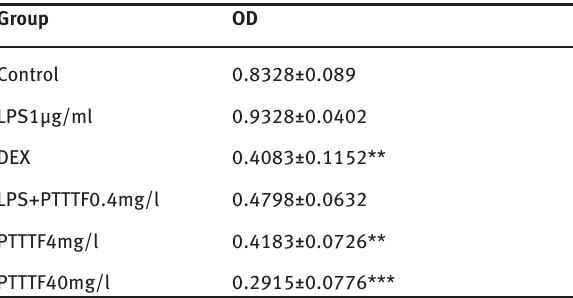
Table 2: Effect of PTTTF on the phagocytosis of LPS-induced RAW264.7 cells ( n =3).